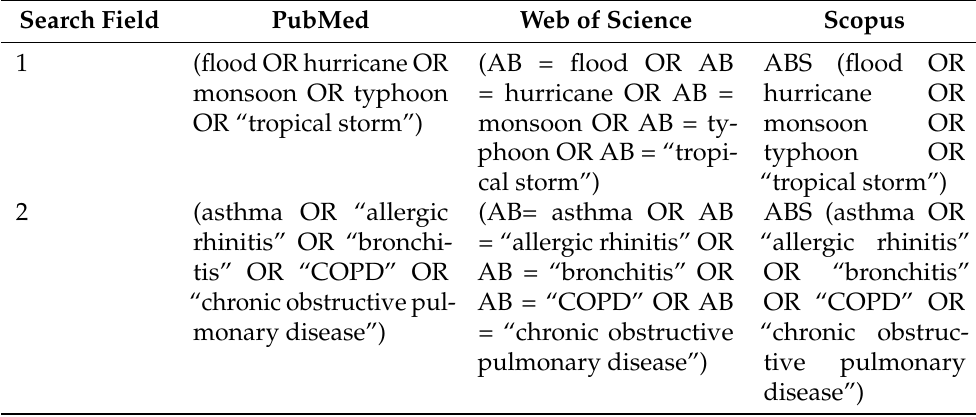
Table 1. Search terms and search strategy for each of the three databases used for this